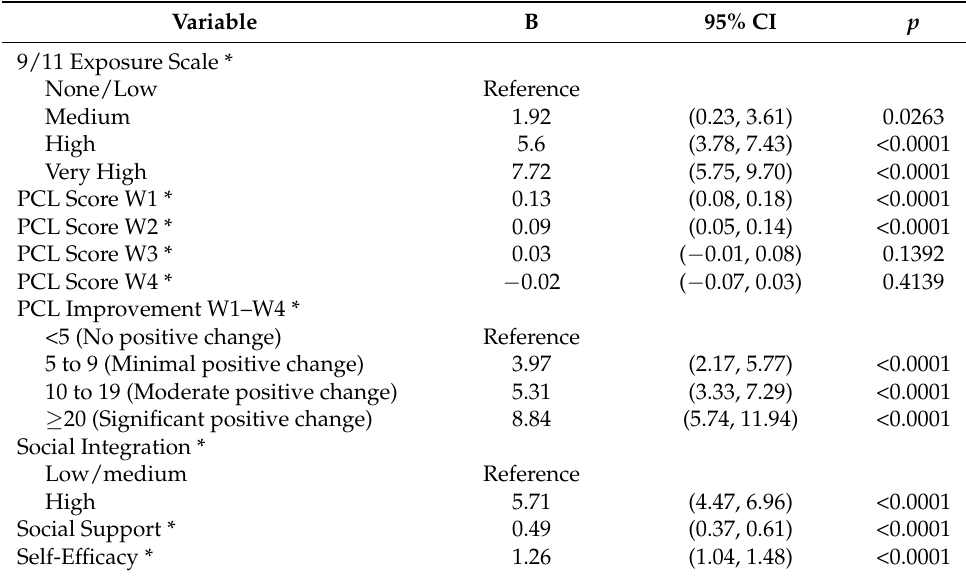
Table 3. Multivariable Linear Regression Models with 9/11 Exposure, PTSS, and Psychosocial Factors with Posttraumatic